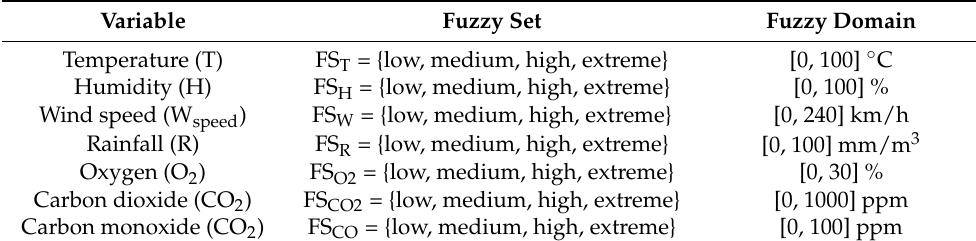
Figure 3. Membership functions of chemical gases, adopted from [57]. Table 3. Fuzzy sets and fuzzy domains proposed for linguistic